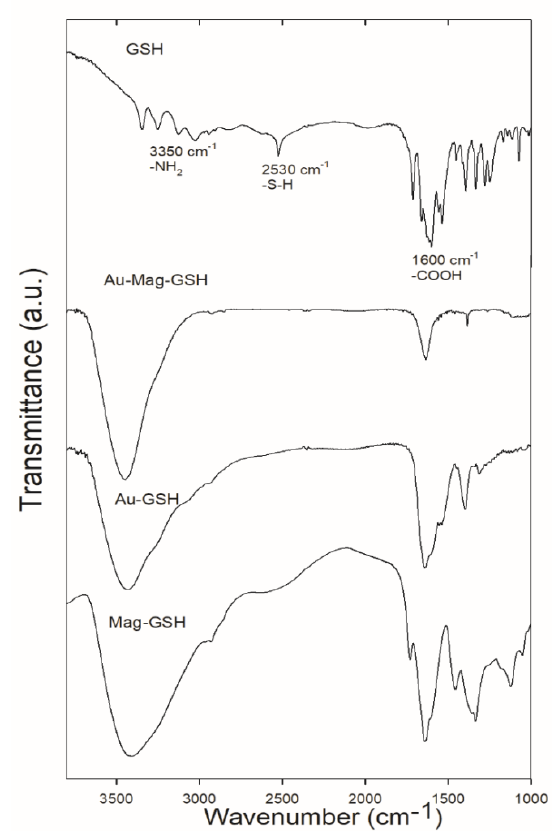
Figure 9. Fourier transform infrared (FTIR) spectra for free GSH ligand as well as for Au-Mag-GSH, Au-GSH and Mag-GSH NPs. Table 3. NPs and their corresponding dynamic light scattering (DLS) hydrodynamic sizes at differ- ent